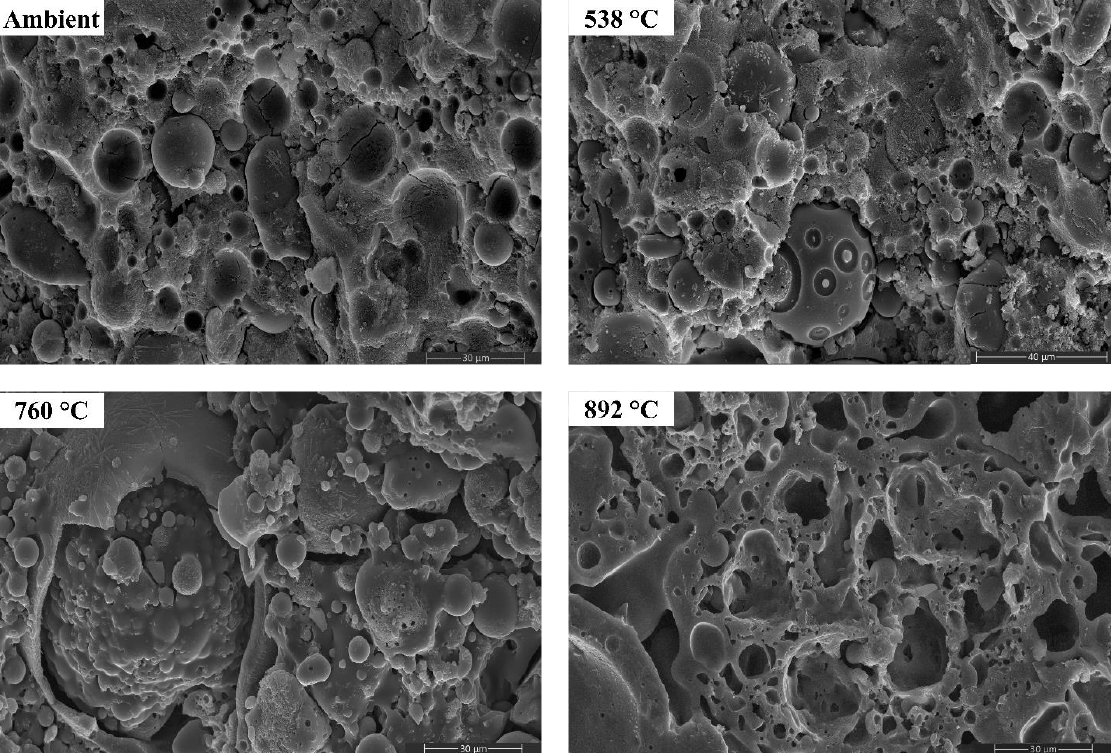
Figure 15. SEM micrographs of FS 0P-1.4 exposed to high temperatures.